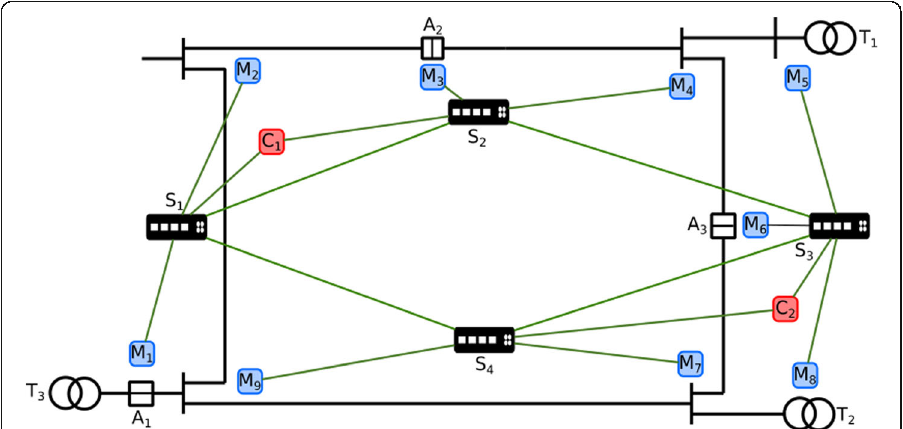
Fig. 1 Power system comprising of ICT and electrical